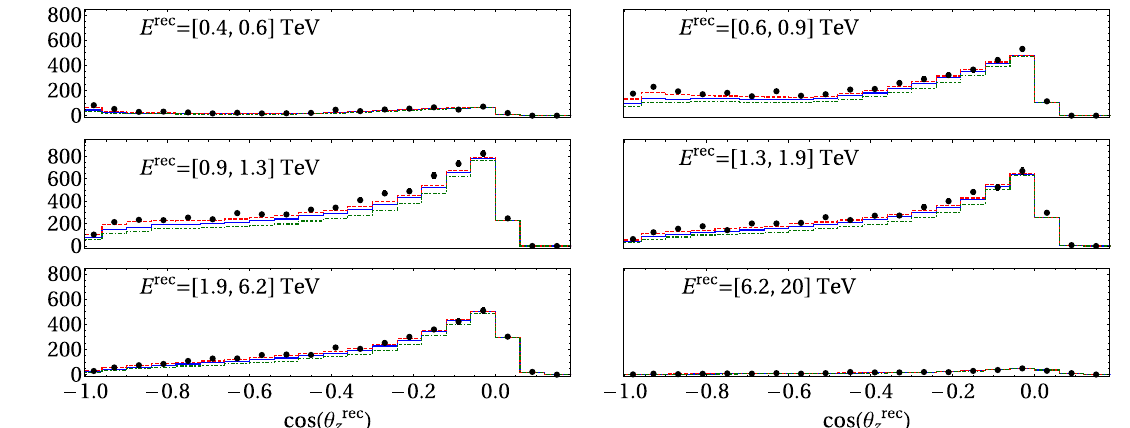
Fig. 3 EventdistributionsobtainedforIceCubeinournumericalsimu- lationsasafunctionofthereconstructedvalueofthecosineofthezenith angle, for neutrinos in different reconstructed energy ranges. The lines have been obtained assuming a normal mass ordering, for the following values for the decoherence parameters: γ 21 = γ 31 = 2 . 3 × 10 − 23 GeV